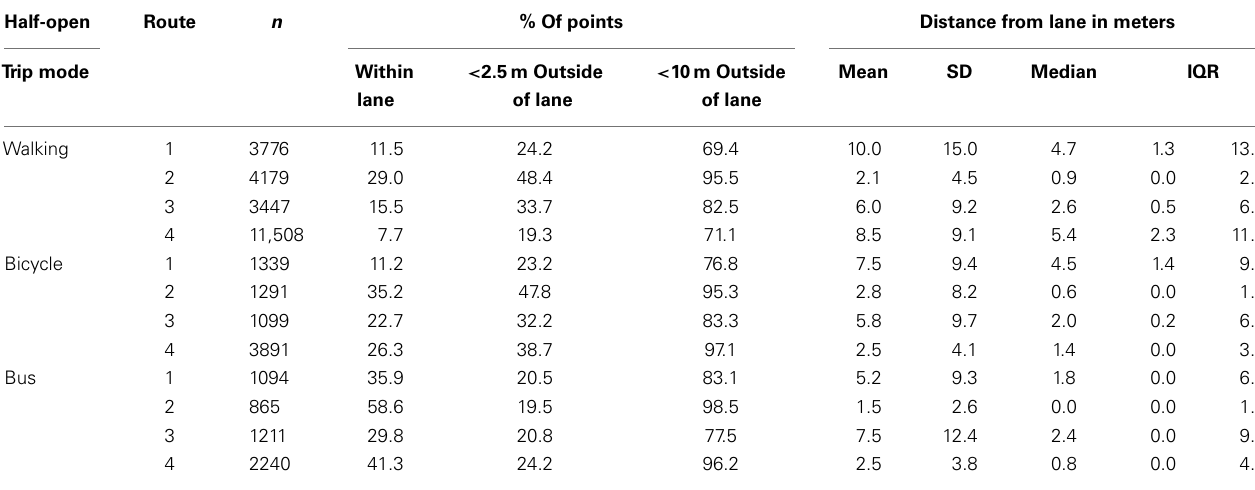
Table 4 | Dynamic spatial accuracy in percent of points and mean and median errors in meters, for four different routes, within three modes of transport, within half-open areas